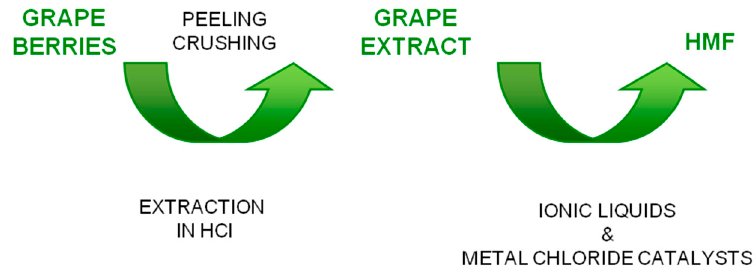
Figure 5. Scheme of the process from grape berries to HMF [ Error! Bookmark not defined. ].